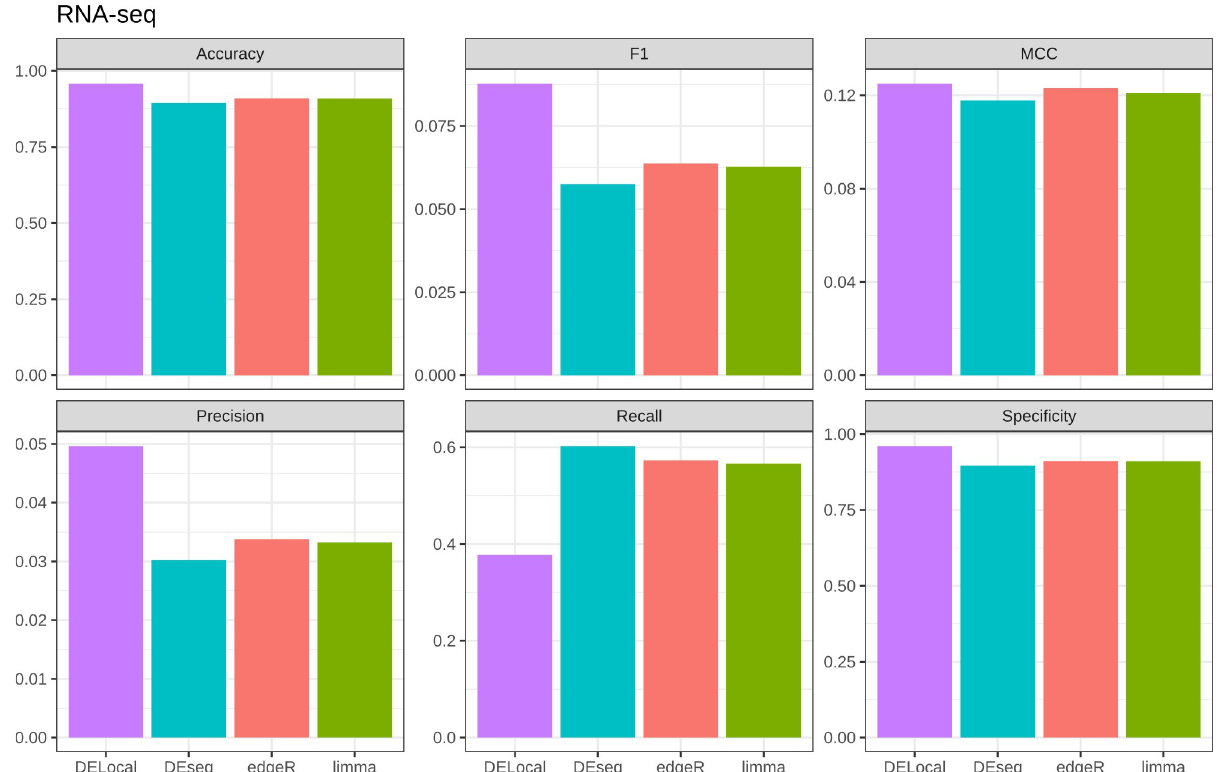
Fig 7. Comparison of DELocal with earlier methods to identify differential expression. Evaluation matrices show that, except for recall (sensitivity), DELocal equals or outperforms earlier methods. However due to large number of true negatives, the significance scores of precision, F1 and MCC remained negligible. The evaluation matrices are explained in Materials and Methods section. The analysis was done using RNAseq data. For microarray data see S5 Fig.